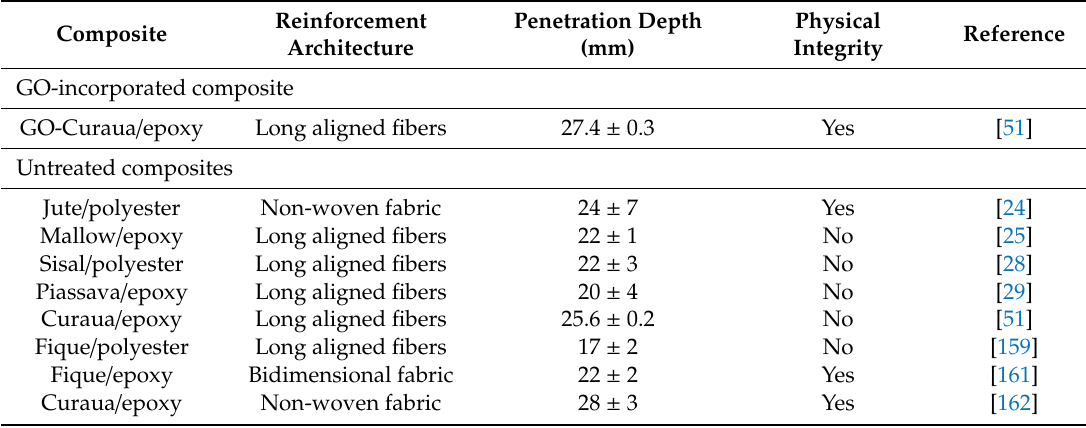
Table 4. Ballistic assessment of different NLFs/polymer composites.